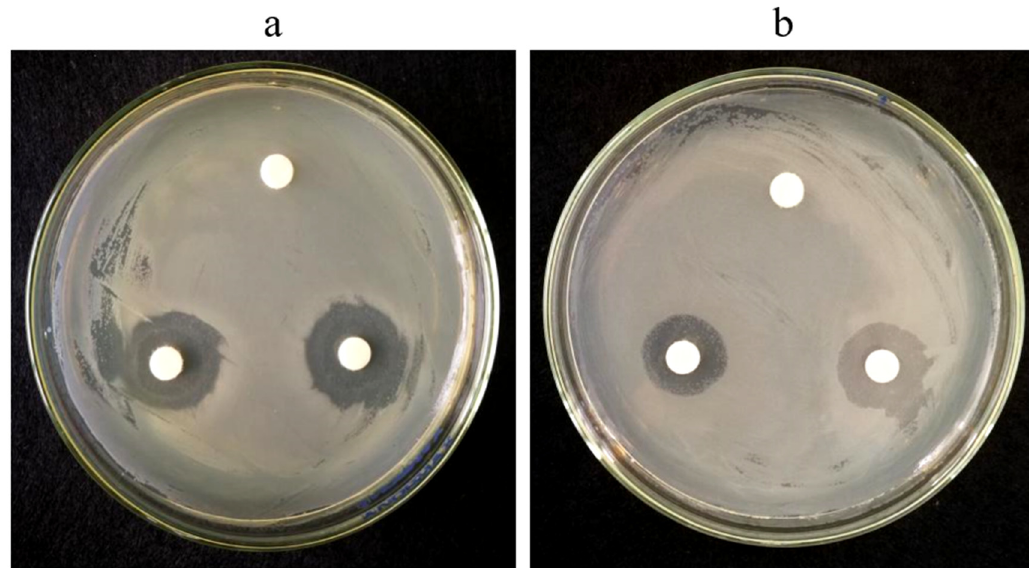
Figure 5. The clearance ability of VC, BHT ( a ) and AgEo ( b ) for ABTS radical.